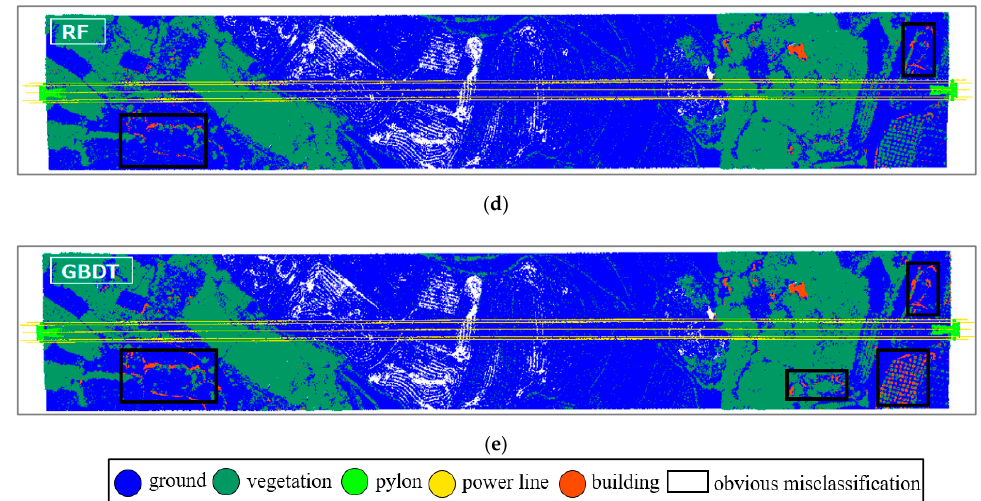
Figure 6. The classification results of site I with different classifiers: ( a ) the point clouds colored by the true labels; ( b ) the point clouds colored by the KNN prediction results; ( c ) the point clouds colored by the LR prediction results; ( d ) the point clouds colored by the RF prediction results; ( e ) the point clouds colored by the GBDT prediction results. The black box is an area of obvious misclassification.